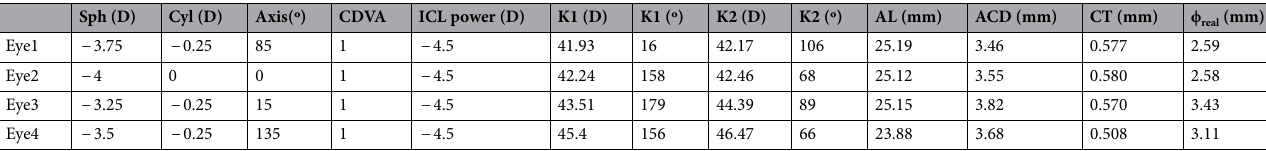
Table 1. Preoperative ocular and biometric parameters of the four eyes*. * Sph (sphere), Cyl (Cylinder), Axis (cylinder axis), CDVA (corrected distance VA), K1 and K2 (keratometries), K1 (º) and K2(º) (keratometric